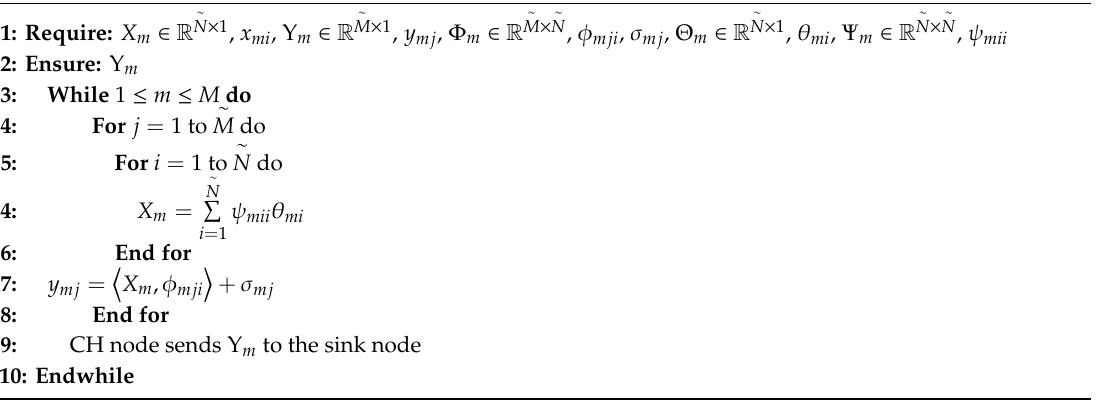
Algorithm 2 CH Node Data Compressed Algorithm